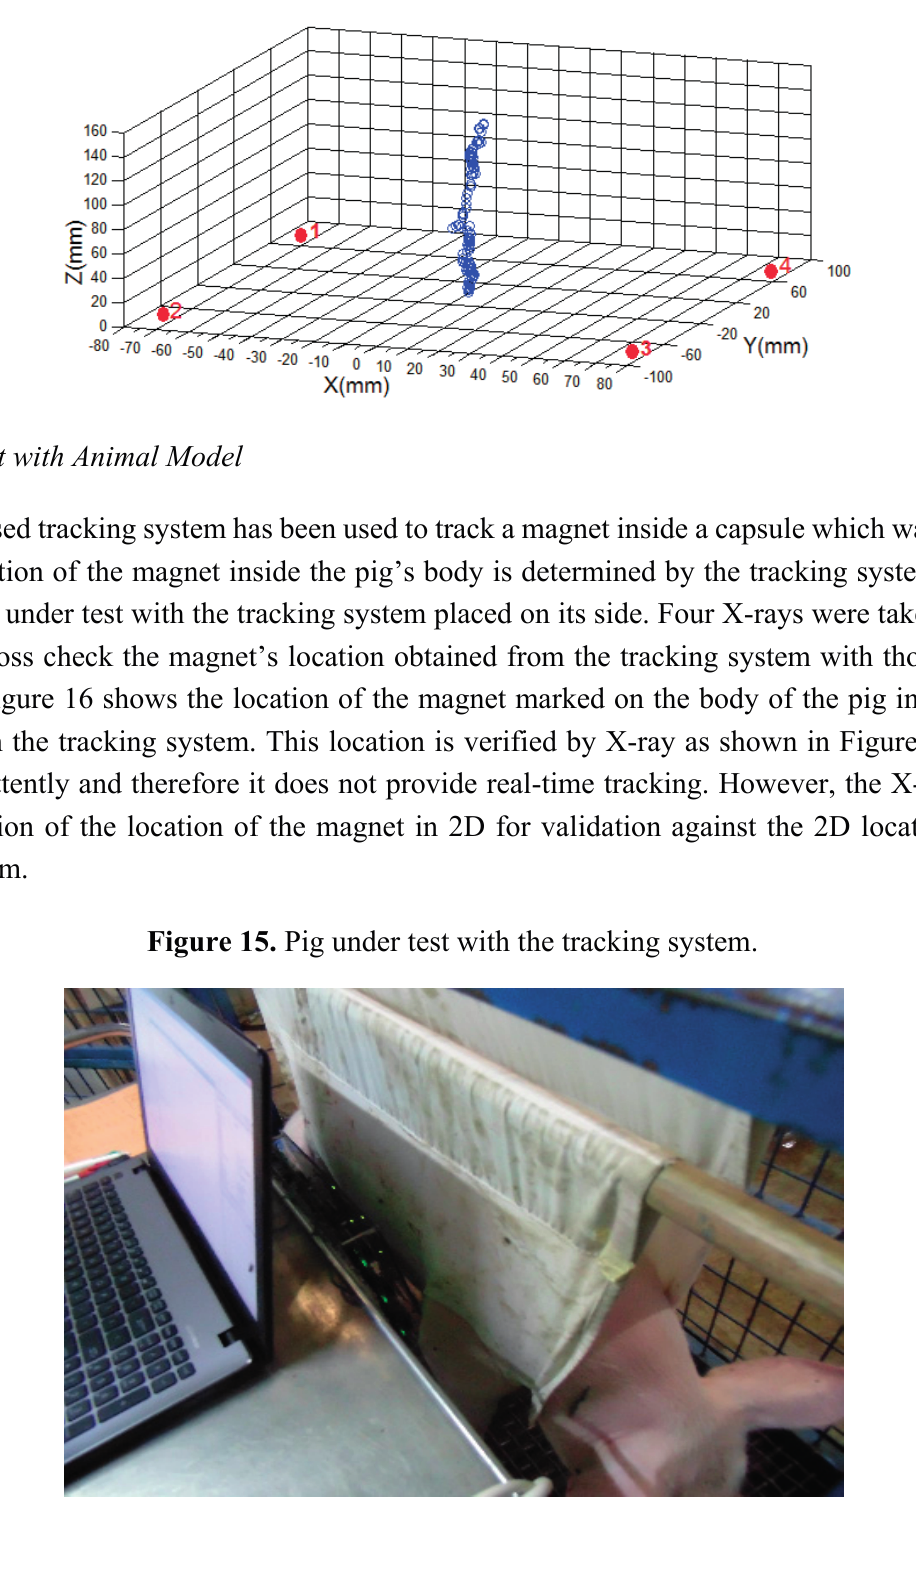
Figure 14. Up-down trajectory test.